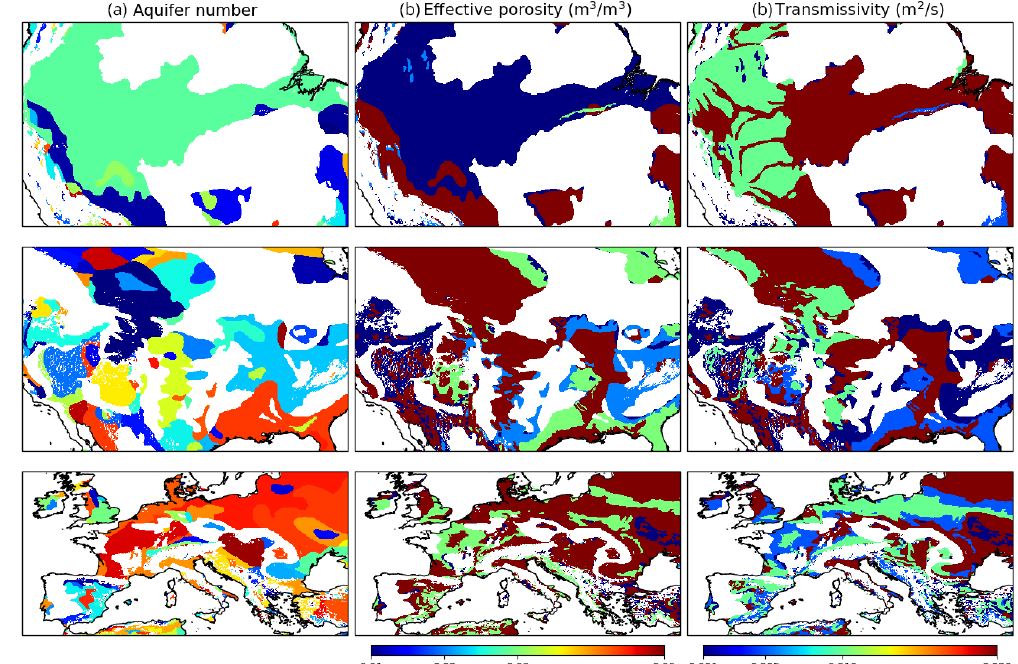
Figure 13. Aquifer numbering and parameters for the Amazon (first row), the USA (second row) and Europe (third row): aquifer number (a) , effective porosity (b) and transmissivity (c)